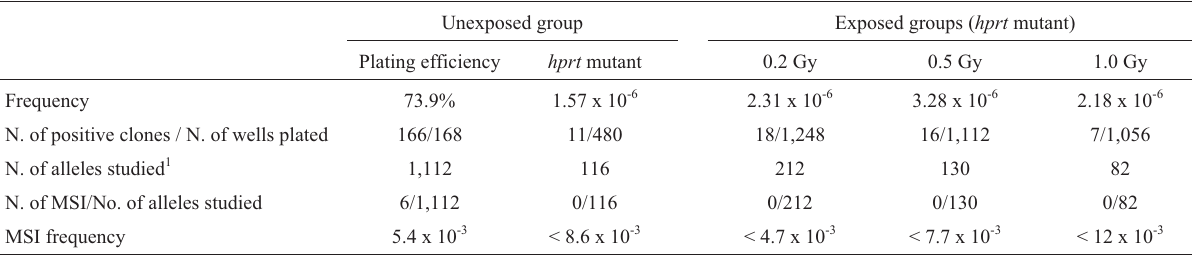
Table 1 - Frequency of MSI at 6 microsatellite loci in TK6 cell clones exposed and unexposed to ionizing radiation. Unexposed group Exposed groups ( hprt mutant)